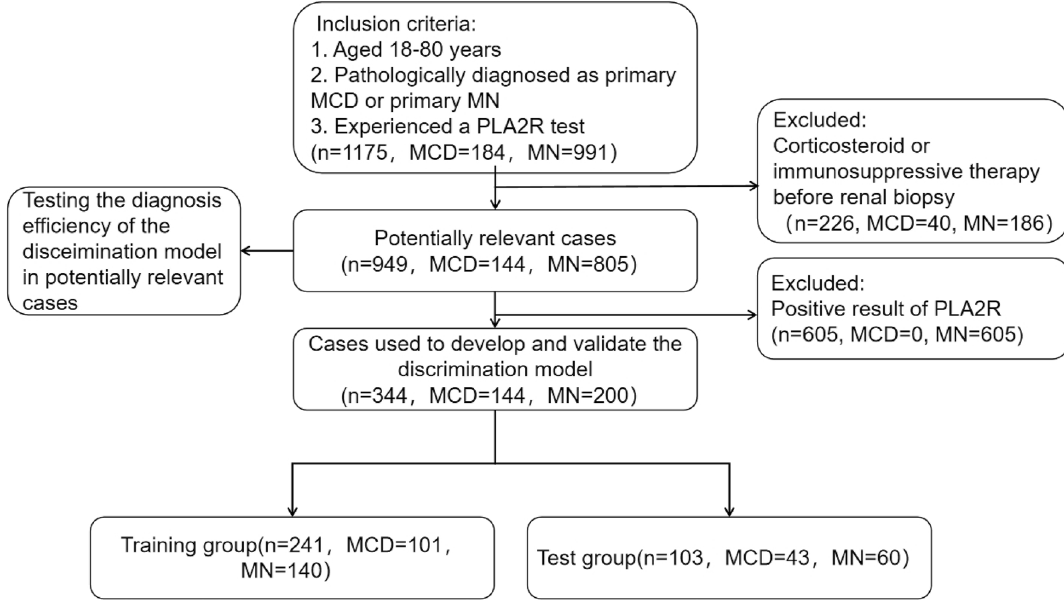
Figure 1. Enrollment flowchart of participants used for model development and validation. MCD minimal change disease, MN membranous